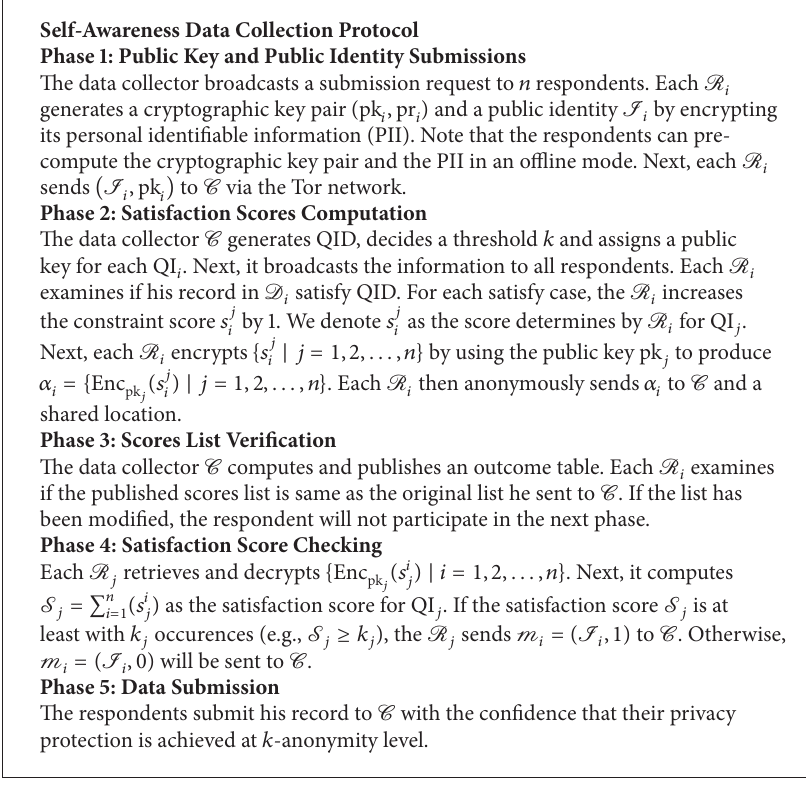
Algorithm 1: Self-Awareness data collection